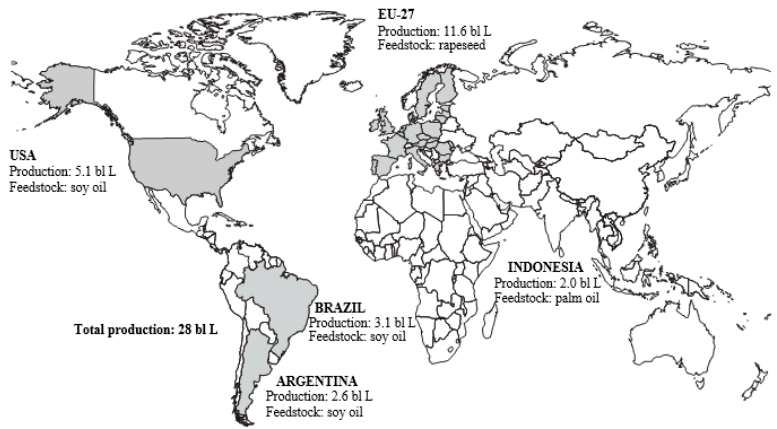
Figure 3. Word biodiesel production, average 2012–2014 [5].